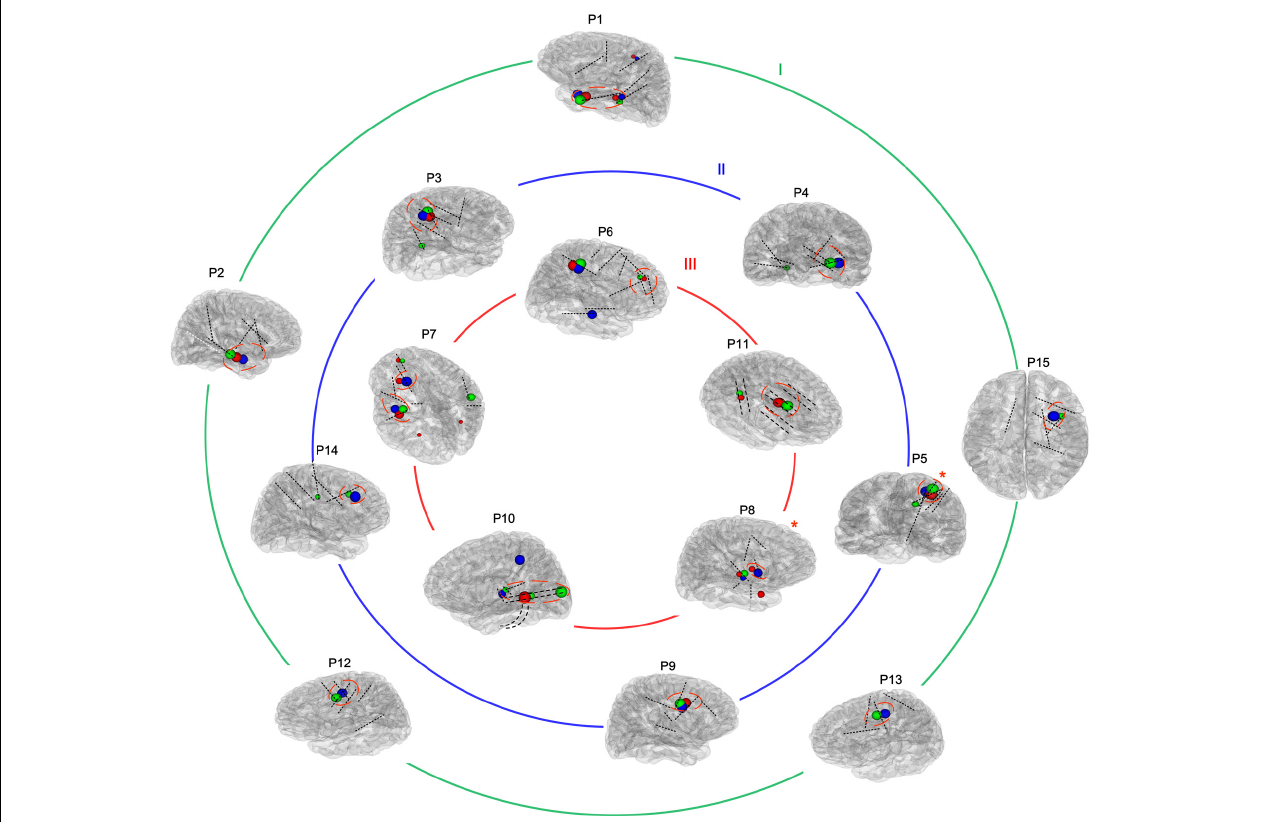
FIGURE 1 | Reconstructions of the placement of intracranial electrodes and suspicious areas mapped in all patients. The images showed the locations of subdural electrodes (P10 and P11) or SEEG locations in all 15 patients. Most electrodes are shown in black, while one contralateral electrode that was unable to be shown in the brain model is presented in white. Blue, red, and green globes mark suspicious abnormalities detected using positron emission tomography-magnetic resonance imaging (PET-MRI), fluid and white matter suppression (FLAWS), and high-frequency oscillations (HFOs), respectively, and the different volumes indicate different levels of significance. The removed volume is also marked by a red imaginary line. Moreover, all patients were divided into three groups according to their outcomes (Engel I, II, and III), as shown by the three circles. *The patient has undergone radiofrequency ablation instead of